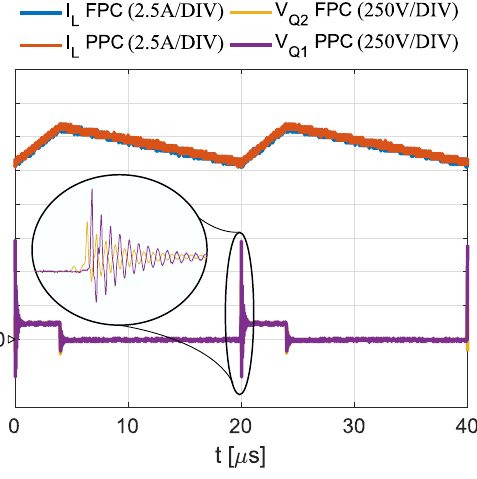
Figure 12. Experimental inductor current obtained by the single-inductor topology. Table 8. Experimental power loss, efficiency, and K pr results obtained with the single-inductor topology.